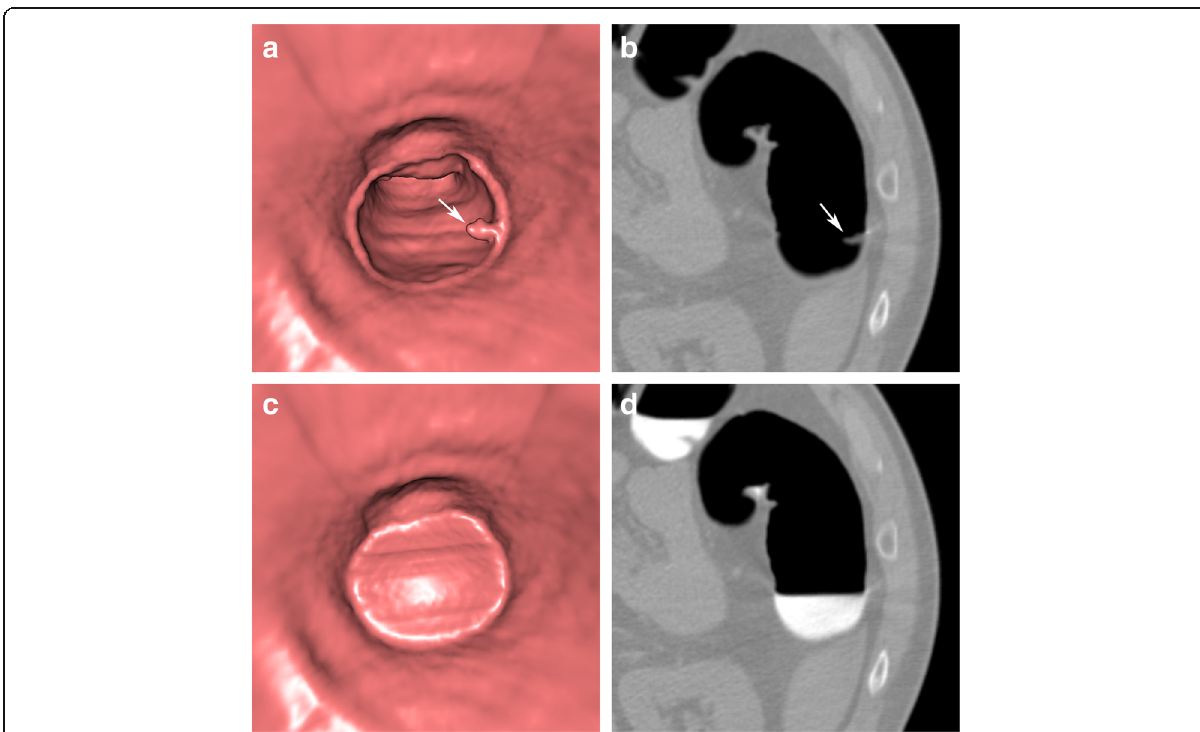
Fig. 5 A pseudopolyp at the interface between tagged residue and air in the descending colon. a Endoluminal 3D and ( b ) axial 2D view after EC, showing irregular pseudopolypoid filling defects (arrow), visible at the interface between tagged residues and air. On corresponding unsubtracted ( c ) 3D and ( d ) 2D views, no lesion is